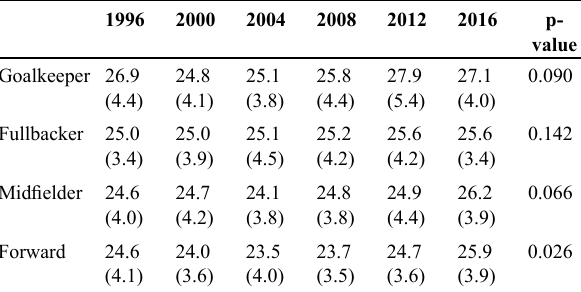
Figure 2 - The average age of women's football players in the Olympic Games from 1996 to 2016. Legend: * statistically different from 1996, 2000, 2004, and 2008 in Kruskal Wallis test (p < 0.001). Table 1 - Age of the players in different tactical positions in the Olympic Games from 1996 to 2016.